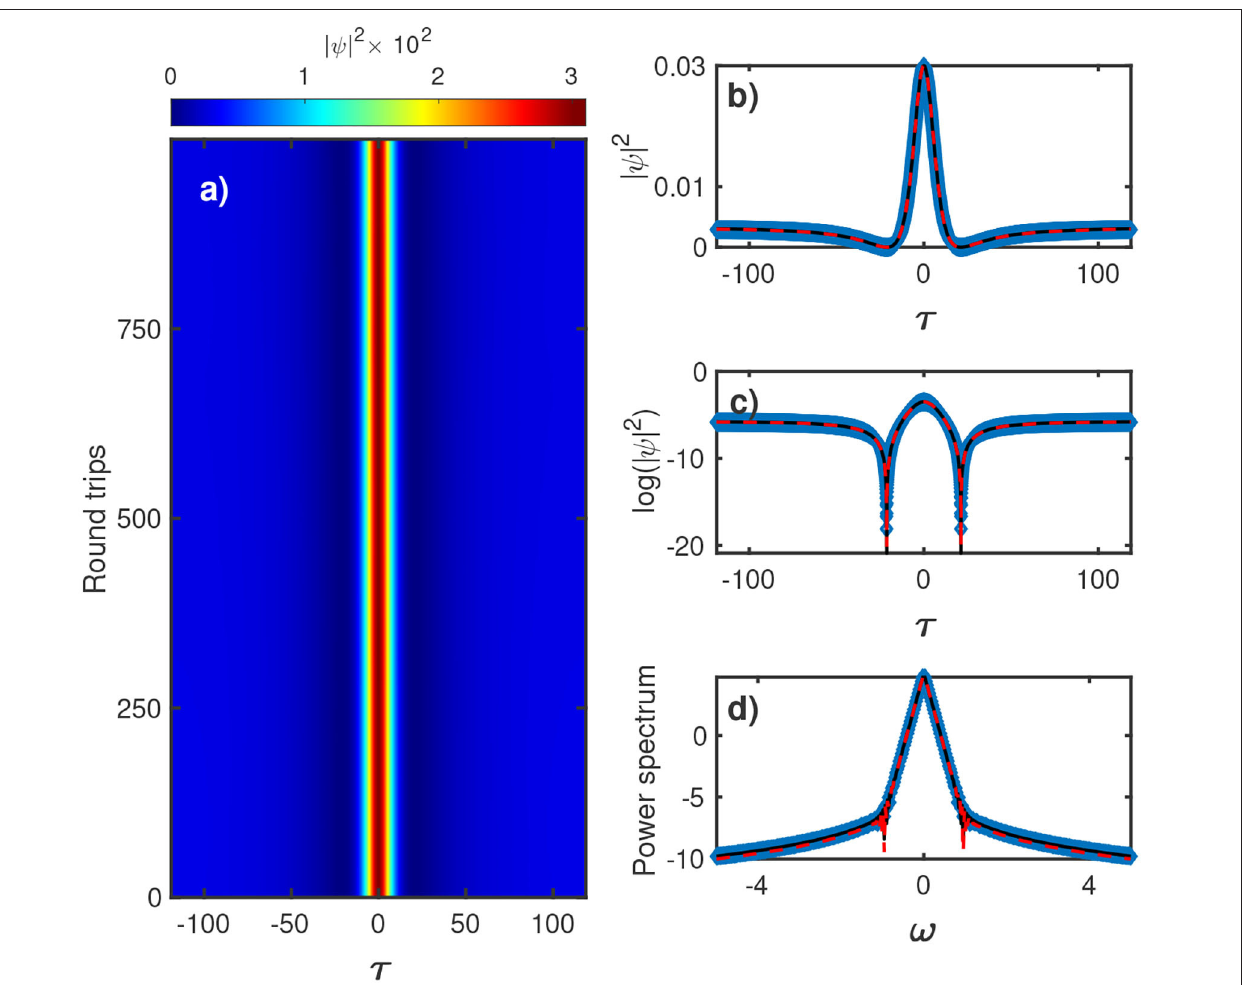
FIGURE 1 | Localized structure of the driven dissipative non-linear Schrödinger Equation (3). (a) Evolution of the driven dissipative non-linear Schrödinger obtained by integration of Equation (3) with α 10 − 5 , δ 10 − 2 , and S 4 10 − 4 . In the right panel, (b–d) , the black dashed lines correspond to the initial condition given by the = = = × stationary Peregine profile (7), blue diamonds correspond to the numerical profile at T 1,000 and the red dash line to the solution from [19], =